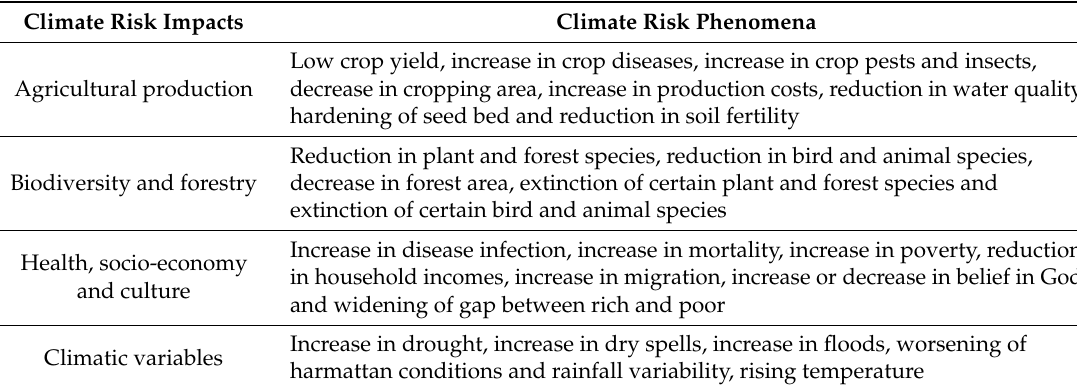
Table 6. Climate risk impacts and